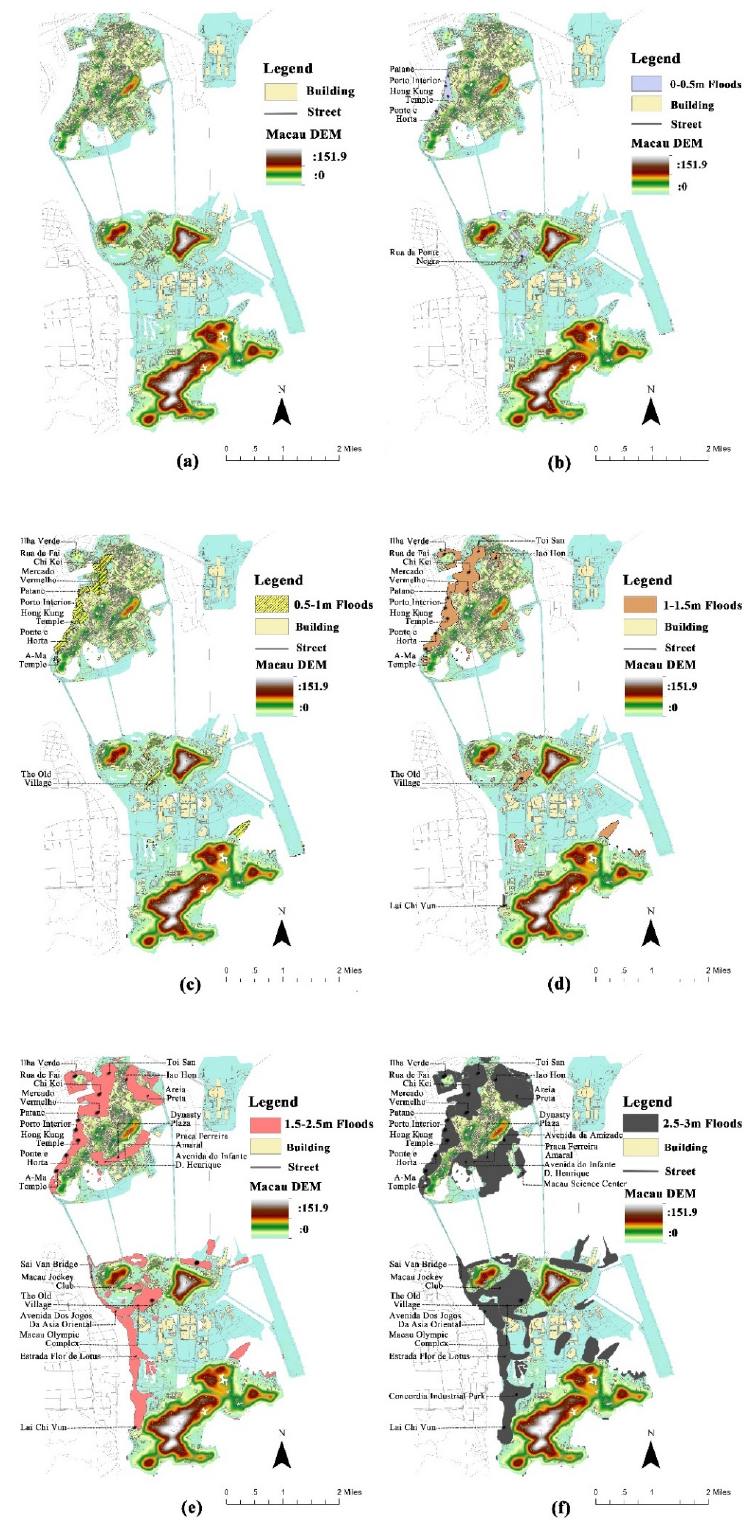
Figure 4. Spatial extent a ff ected by urban floods. ( a ) Digital elevation model (DEM) of buildings and roads in Macau [35]; ( b ) SSW Level 1 (blue) flooding simulation results (0–0.5 m floods); ( c ) SSW Level 2 (yellow) flooding simulation results (0.5–1 m floods); ( d ) SSW Level 3 (orange) flooding simulation results (1–1.5 m floods); ( e ) SSW Level 4 (red) flooding simulation results (1.5–2.5 m floods); ( f ) SSW Level 5 (black) flooding simulation results (2.5–3.0 m